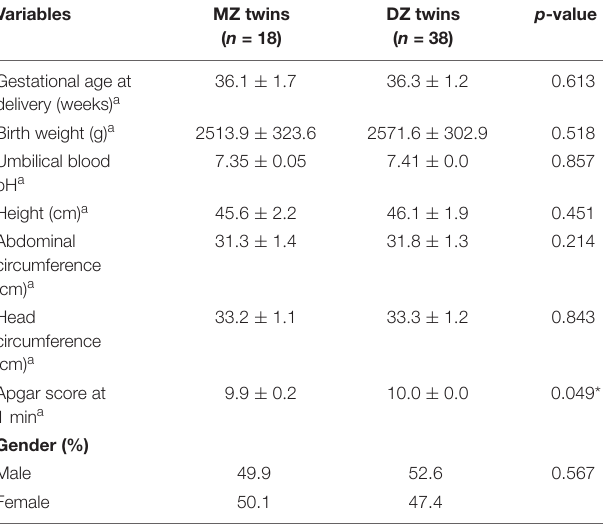
TABLE 2 | Characteristics of neonatal outcomes ( n =